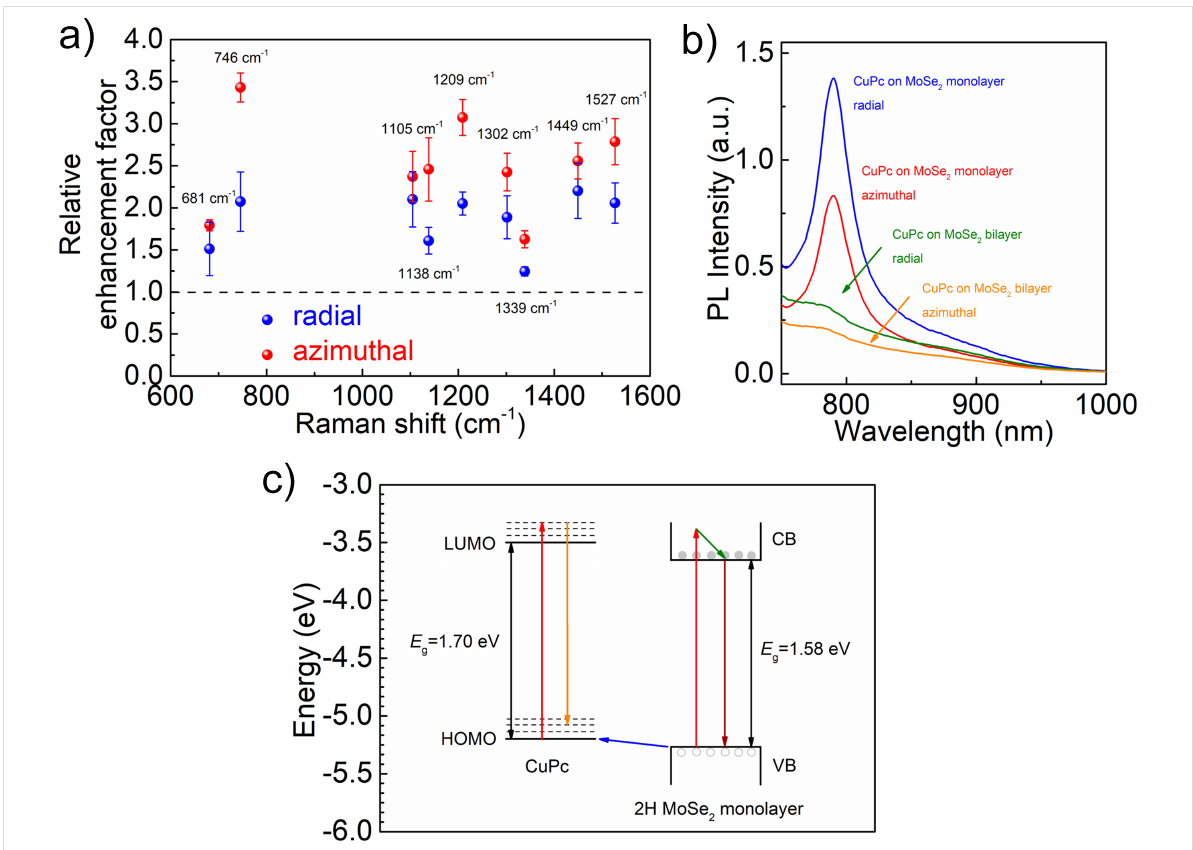
Figure 3: (a) Relative Raman enhancement factor at the center of the MoSe 2 flake in reference to the SiO 2 /Si substrate. (b) Photoluminescence spectra collected at the border region (bilayer) and the center position (monolayer) of CuPc on MoSe 2 flake. The photoluminescence peak is due to the direct bandgap emission in the MoSe 2 monolayer. (c) A sketch of the energy level diagram at the interface between CuPc molecule and 2H MoSe 2 monolayer. The ground-state charge transfer, represented by the blue arrow, occurs from the valence band of the MoSe 2 monolayer to the HOMO of the CuPc molecule. Left side: the red arrow denotes the HOMO–LUMO transition in CuPc excited by a 636 nm laser. The yellow arrow indi- cates the Raman scattering process. Right side: the absorption process in the MoSe 2 monolayer is indicated by the red arrow. The olive arrow denotes the non-radiative relaxation process. The photoluminescence emission in MoSe 2 monolayer is represented by the wine red arrow.